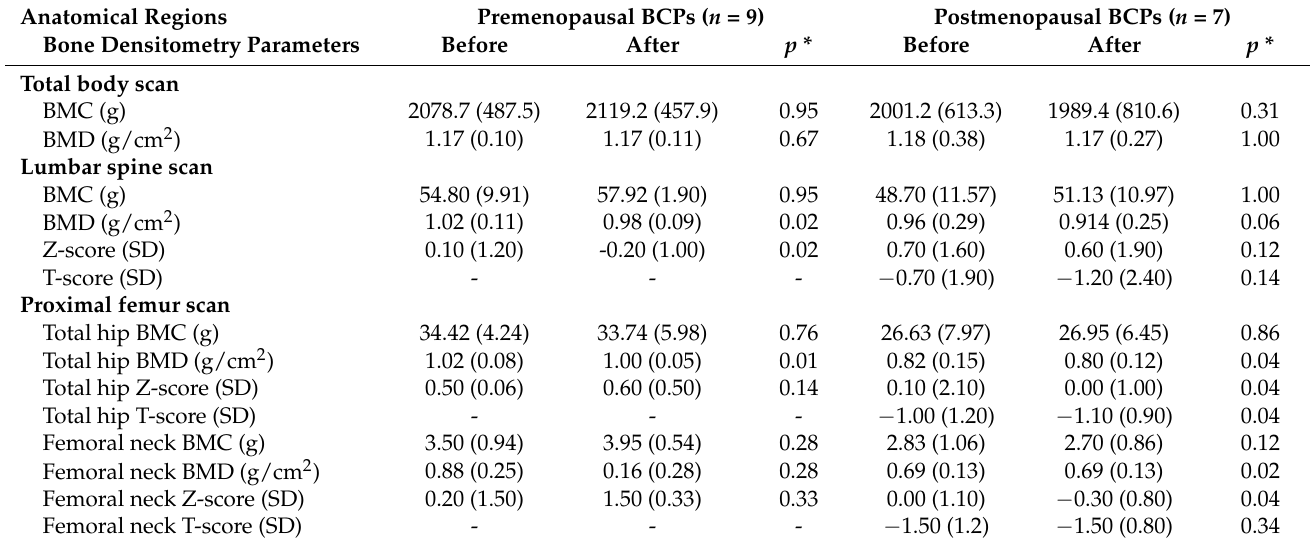
Table 2. Changes in bone densitometry of breast cancer patients in the subsample before and after six months of antineoplastic treatment and nutrition